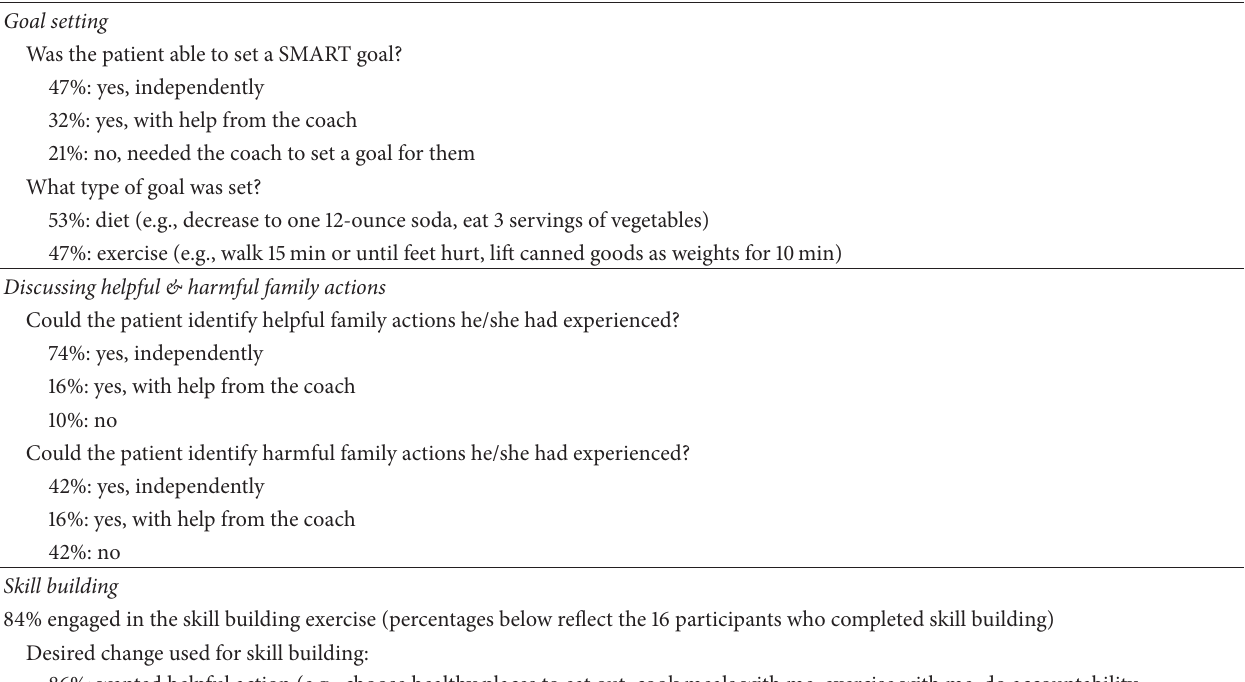
Table 5: Coaching Assessment data evaluating FAMS protocol